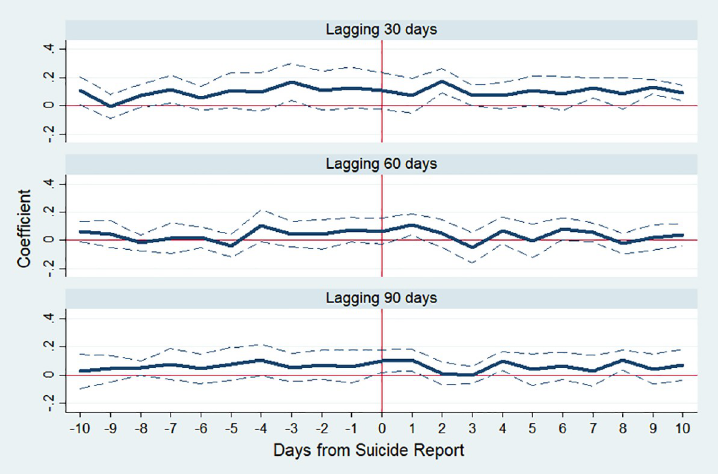
Fig 11. Estimated changes in total suicides using different lags. Note: We assign lags of 30, 60, and 90 days to the actual dates of celebrity suicides. The y -axis indicates an approximate percent change in public suicide by corresponding day, which is the estimated β k in Eq (1). The dotted lines indicate 95% confidence interval.